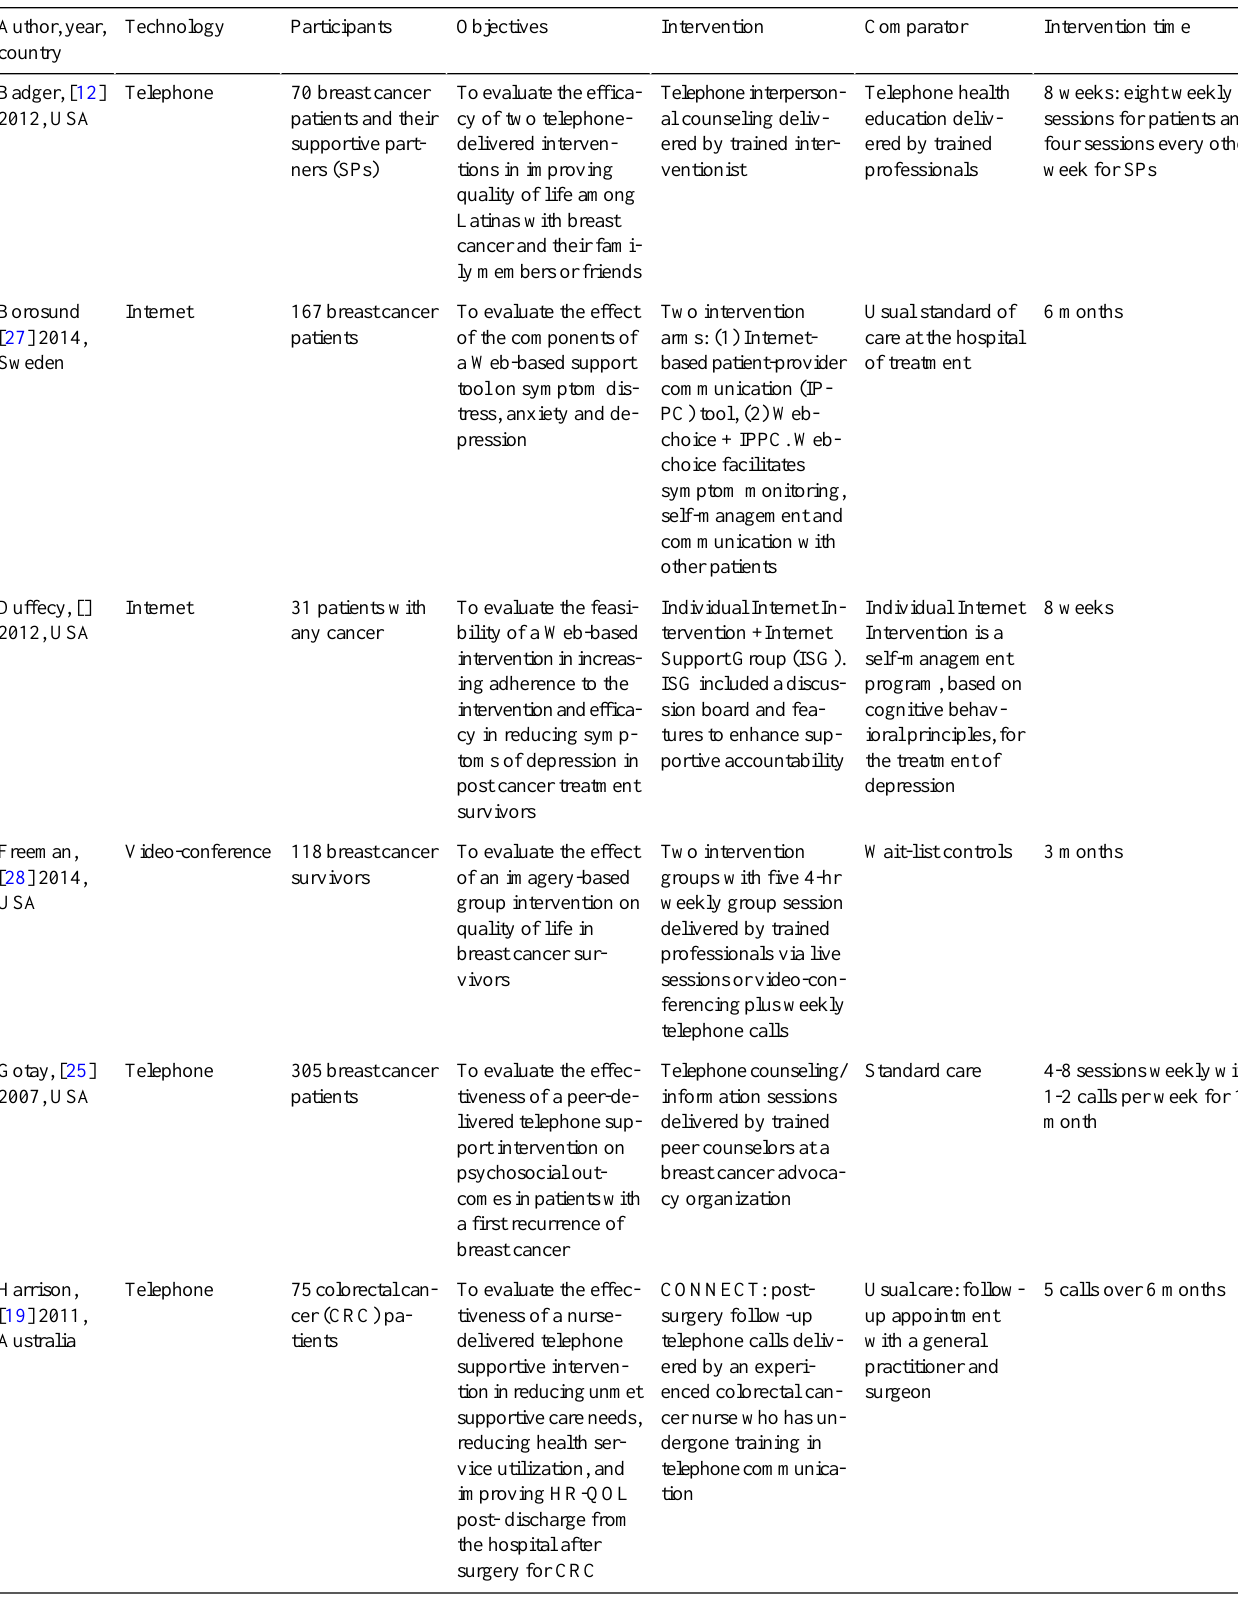
Table 1. Characteristics of randomized trials included in the systematic review on telehealth for cancer patients a